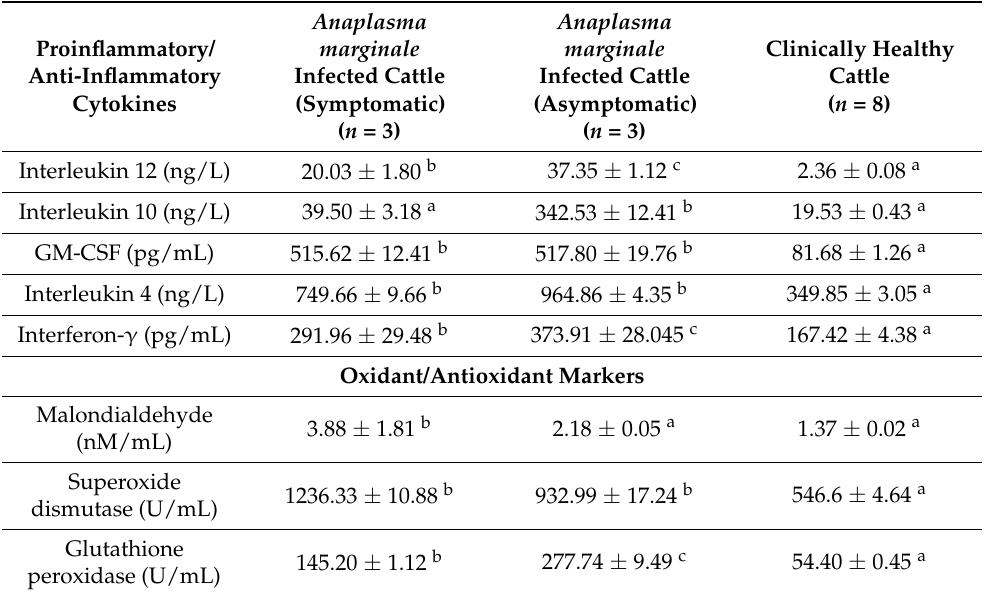
Table 5. The serum inflammatory cytokine and oxidant/antioxidant levels in symptomatic and asymptomatic cattle naturally infected by Anaplasma marginale